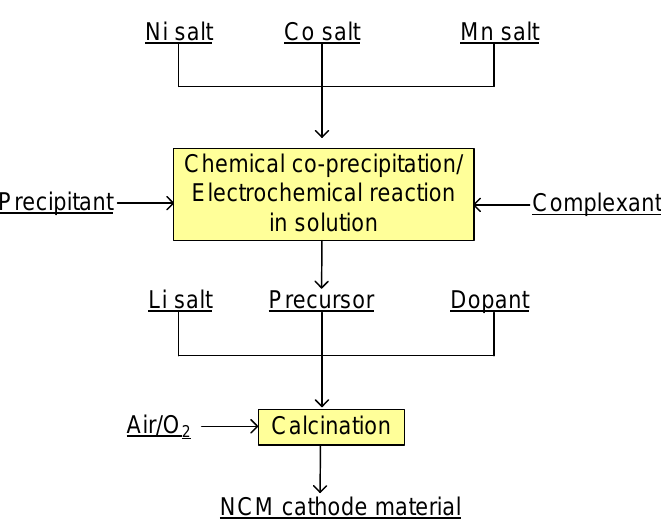
Figure 1. The common flowchart for the synthesis of NCM cathode material.